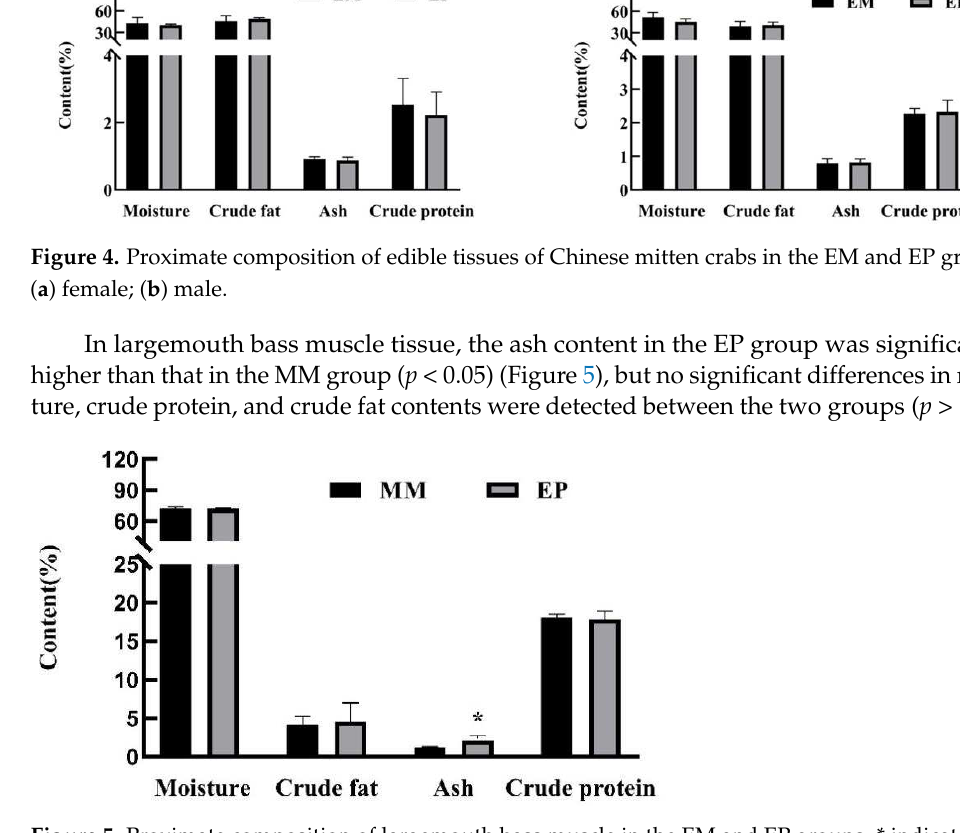
Figure 3. Differences in ( a ) CAT, ( b ) GSH-Px, ( c ) SOD, ( d ) ACP, and ( e ) AKP activities in largemouth bass at different time points. Data are means ± SD. * indicates statistically significant differences between the MM and EP groups at each time point ( p < 0.05).